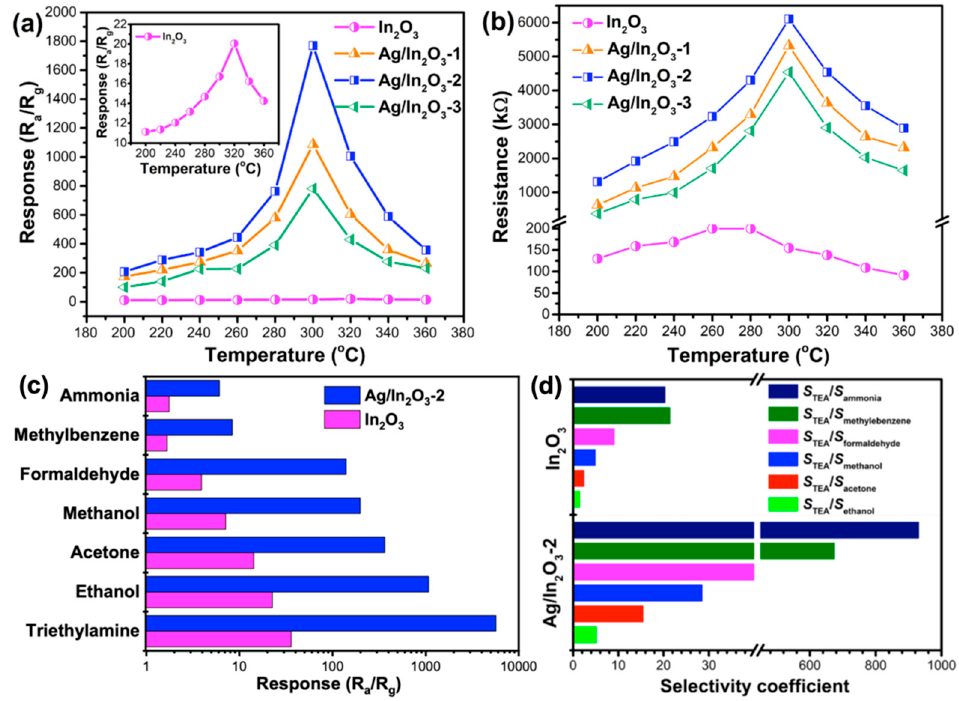
Figure 5. ( a ) Temperature-dependent responses of the sensors to 20 ppm TEA, and ( b ) baseline resistances of the sensors at different operating temperatures. ( c ) Responses of In 2 O 3 and Ag/In 2 O 3 -2 to different gases (50 ppm) at 300 °C, and ( d ) corresponding selectivity coefficients by using TEA as target gas.